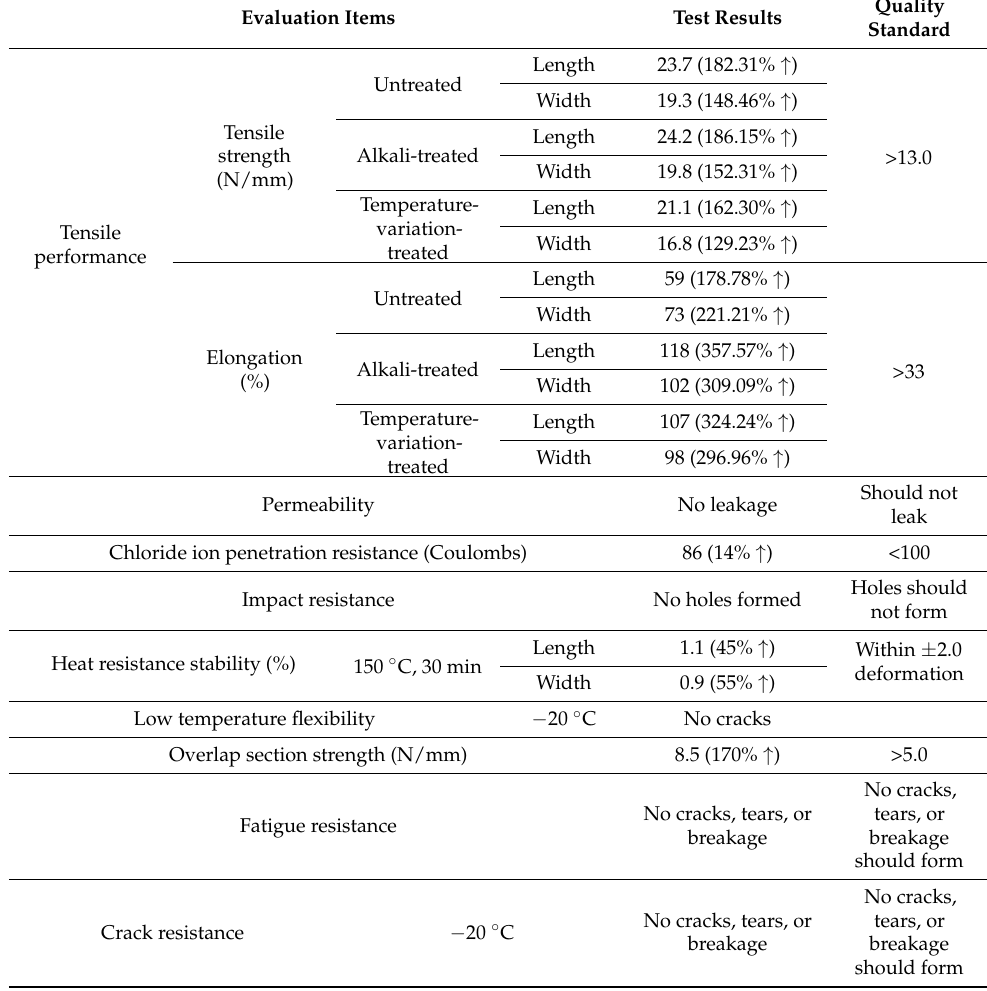
Table 7. Performance test results of double-sided waterproofing